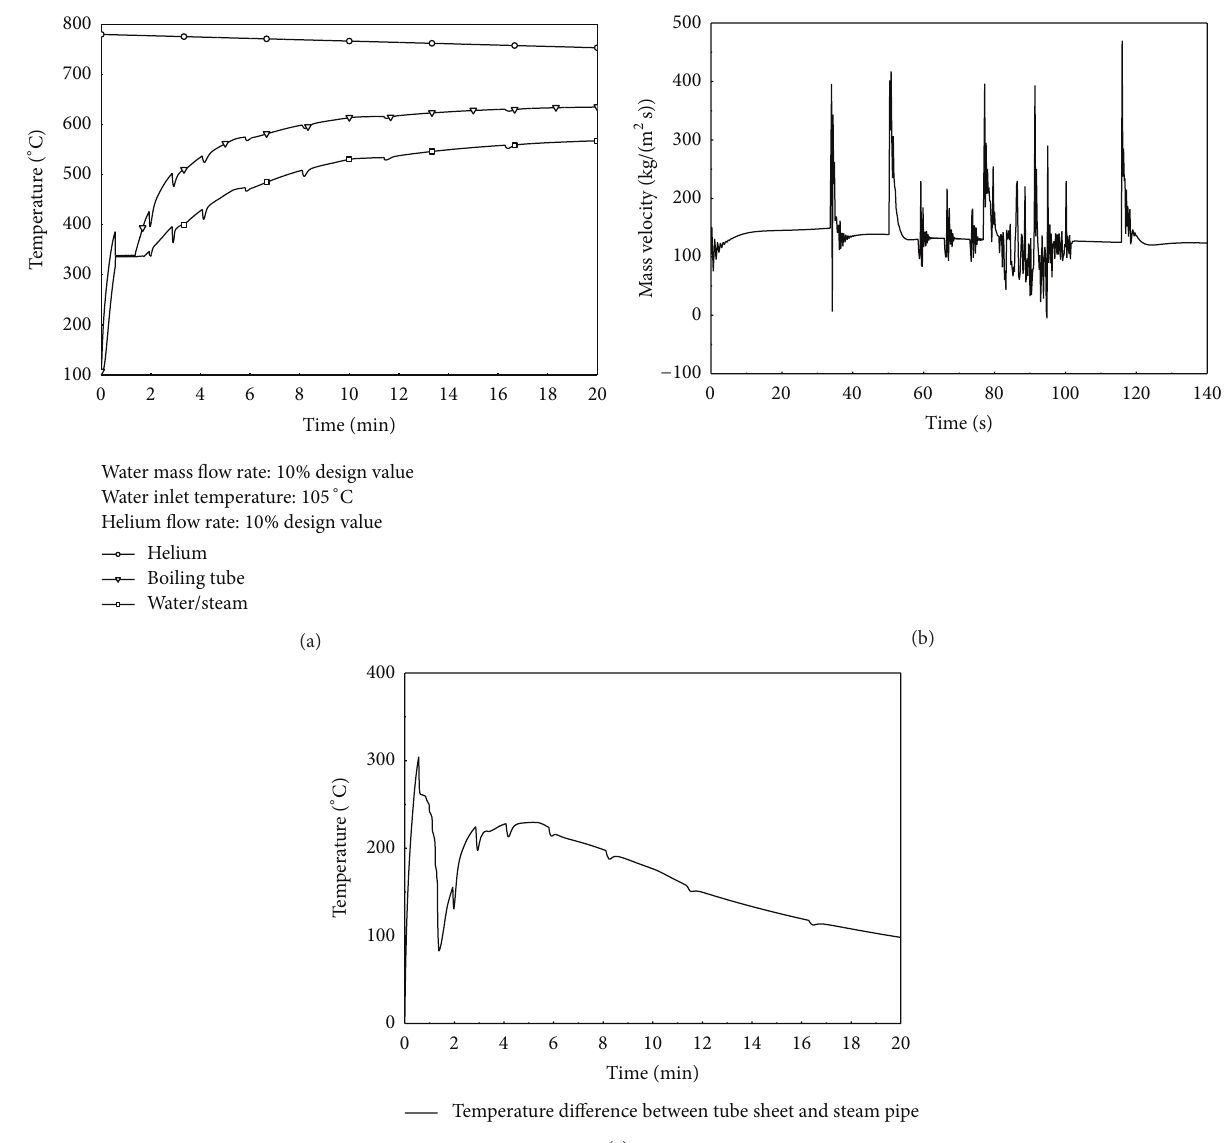
Figure 12: Temperature transient of SG outlet during cooling of reactor core; water mass flow rate: 10% design value; inlet temperature: 105 ∘ C; pressure: 13.9 MPa; and helium mass flow rate: 10% design value: (a) temperature of SG outlet; (b) flow oscillation; and (c) temperature difference between tube sheet and steam